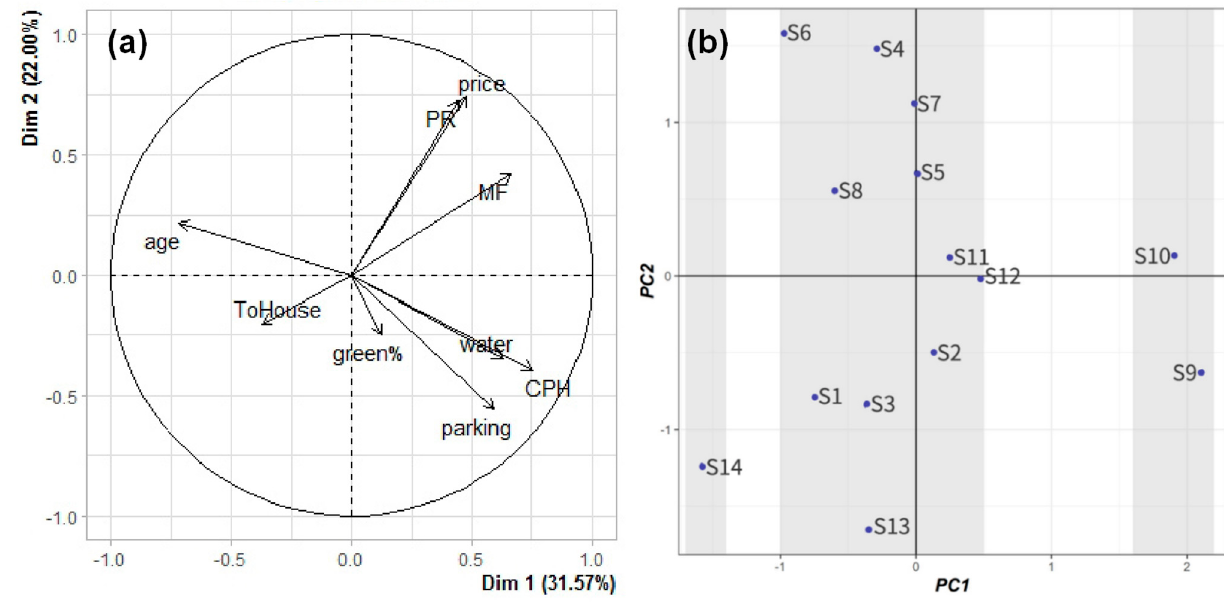
Figure 5. ( a ) The plot of 9 variable loadings with varimax rotation. ( b ) The plot of principal component scores of the 14 communities on PCs: price , housing price; age , age of the building (until 2017); PR , plot ratio; MF , management fees; ToHouse , total number of households; parking , number of parking sites; CPH , number of parking sites per household; green% , green area ratio; water , the average water consumption per household in the community.